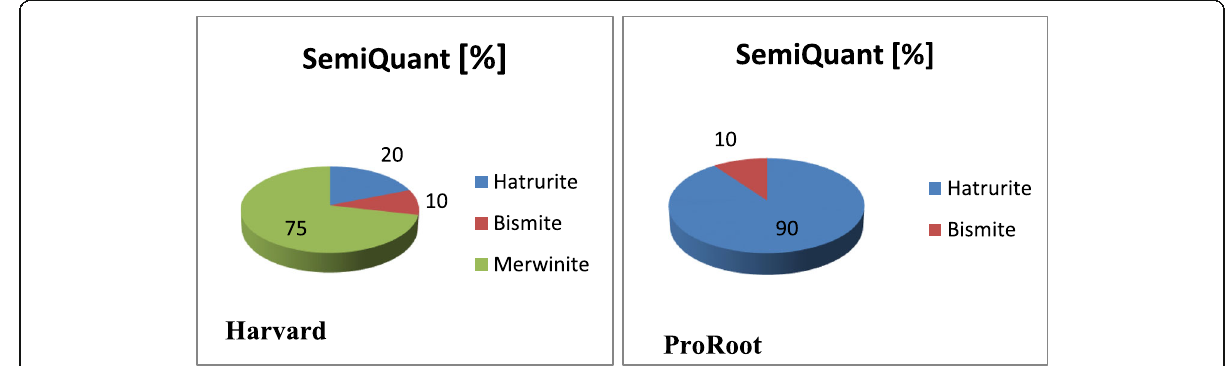
Fig. 2 Minerals ’ percentage of XRD analysis for Harvard and ProRoot endodontic